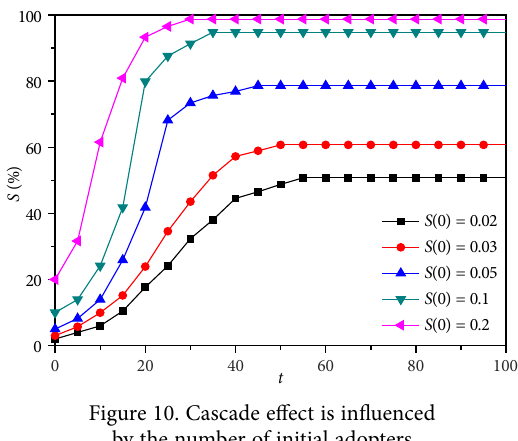
Figure 10. Cascade effect is influenced by the number of initial adopters